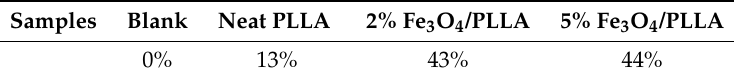
Figure 5. Histological images of samples grafted with: ( a ) blank; ( b ) neat PLLA; ( c ) 2% Fe 3 O 4 /PLLA; and ( d ) 5% Fe 3 O 4 /PLLA nanofibers after eight weeks. Scale bar: 2 mm. Table 1. Quantification of the new bone formation ratio